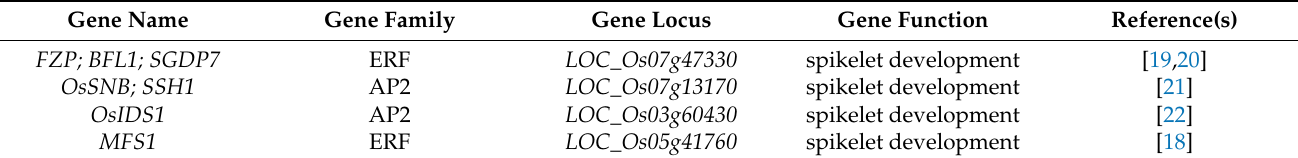
Table 2. The genes associated with spikelet determinacy and organ development in rice.